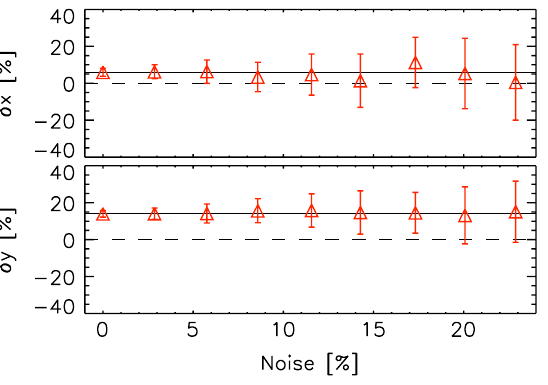
FIG. 9. Uniformity along the two directions of the recon- structed phantom 8 as a function of the noise added to the line-integrated signals. The dotted line corresponds to complete uniformity along that direction, while the continuous line cor- responds to the level of nonuniformity of the simulated